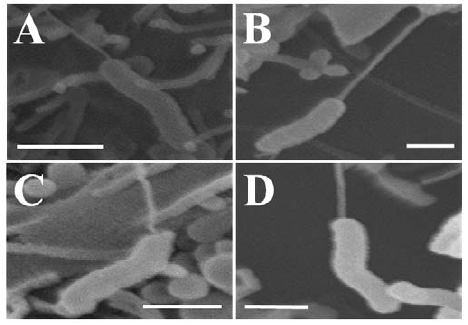
Figure 1. Scanning electron microscopy of four Campylobacter concisus strains. C. concisus UNSW2 was observed as spiral curved- shaped bacteria with rounded ends and a single polar flagellum as shown in Panel A (bar=3 m m). In Panel B (bar=1.5 m m) C. concisus UNSW3 was observed to be curved-shaped bacteria with rounded ends and a single polar flagellum, while in Panels C (bar=2 m m) and D (bar=2.5 m m) C. concisus strains UNSW1 and UNSWCD were shown to be spiral curved-shaped bacterium with rounded ends and a single flagellum.